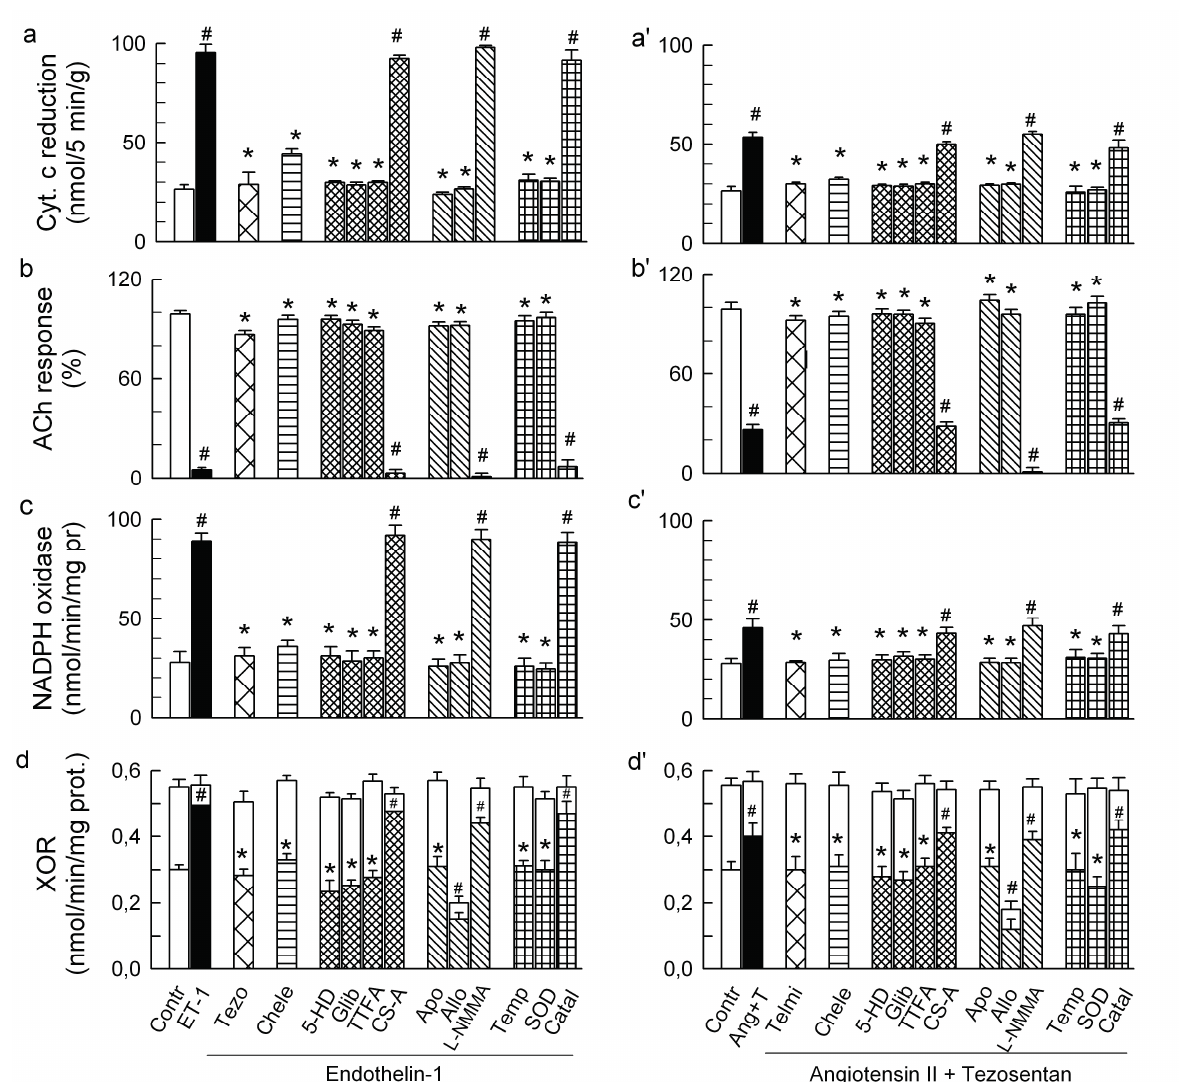
Figure 3. Effect of endothelin-1 (ET-1, 25 pM) ( a – d ) and angiotensin II (20 nM) combined with tezosentan (5 nM) (Ang-T, a' – d' ) on: total outflow of reduced cytochrome c (as measured during the initial 5 min of the treatment) ( a , a' ); normalised acetylcholine (ACh) response ( b , b' ); NADPH oxidase activity (studied by NADPH-stimulated cytochrome c reduction) ( c , c' ); and xanthine oxidoreductase (XOR) activity (open and hatched parts of the columns represent xanthine dehydrogenase and xanthine oxidase proportion in the total XOR) ( d , d' ) in guinea-pig hearts. ET-1 and Ang-T were administered either alone or together with (from left to right): 5 nM tezosentan (Tezo) or 7.5 μ M telmisartan (Telmi), 4 μ M chelerythrine (Chele), 100 μ M 5HD, 3 μ M 250 μ M allopurinol (Allo), 50 μ M L-NMMA, 2.5 μ M tempol (Temp), 150 IU/mL SOD, and 600 U/mL catalase (Catal). Values are means ± SEM of at least 6 experiments. # p < 0.05 vs. control; * p < 0.05 vs. ET-1 and Ang-T group,